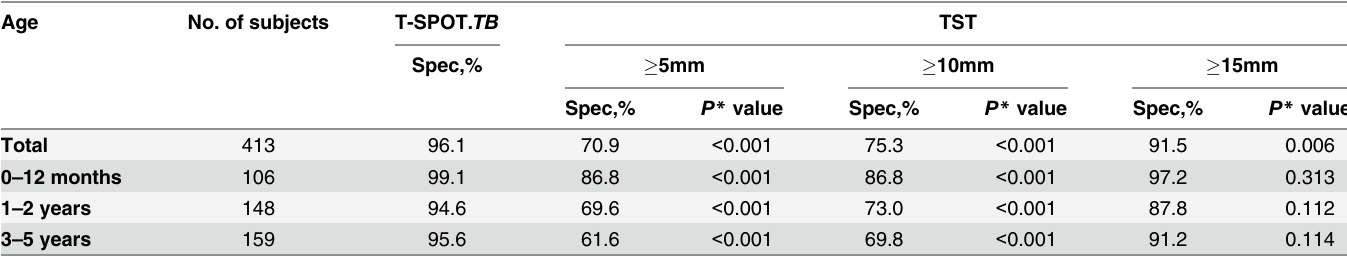
Table 3. Specificity of the T-SPOT.TB and TST for active TB disease. Age No. of subjects T-SPOT.